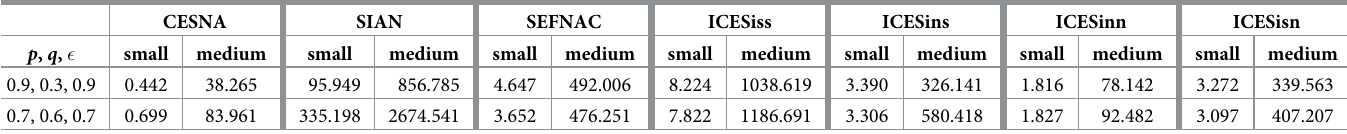
Table 12. The execution time of methods under consideration at synthetic networks with categorical features at the nodes. The average of 10 different data sets of the same setting is reported in seconds.